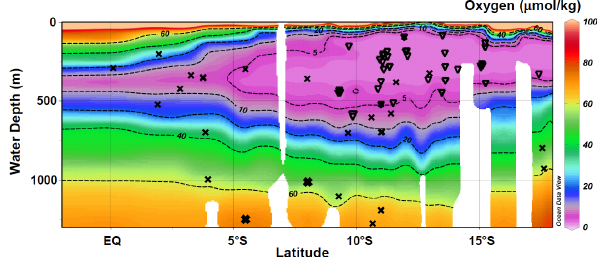
Figure 2. Oxygen concentrations of a composite section along the Peruvian continental margin and locations of sediment cores. Trian- gles: cores with laminated intervals. Crosses: non-laminated